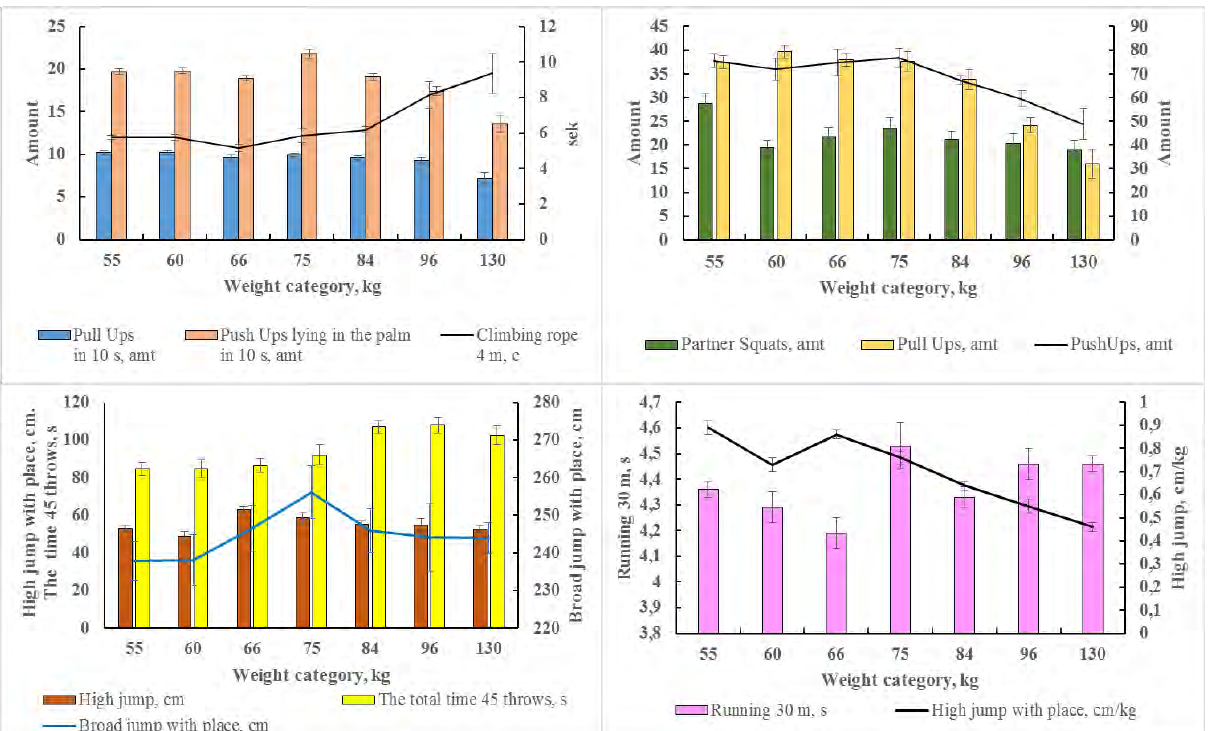
Fig.1 Some indicators of physical fitness of wrestlers of different weight